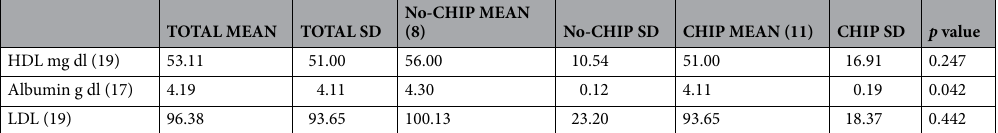
Table 2. Baseline characteristics, echocardiographic and laboratory parameters in patients with and without CHIP for RNA-Seq analysis. Each column displays the mean or the standard deviation (SD) for the continuous variables of both groups (Total), the No-CHIP or the CHIP samples. For dichotomous variables, the total number of each variable and the percentage of the first one are reported. In the last column, the resulting p value for each No-CHIP vs CHIP test is